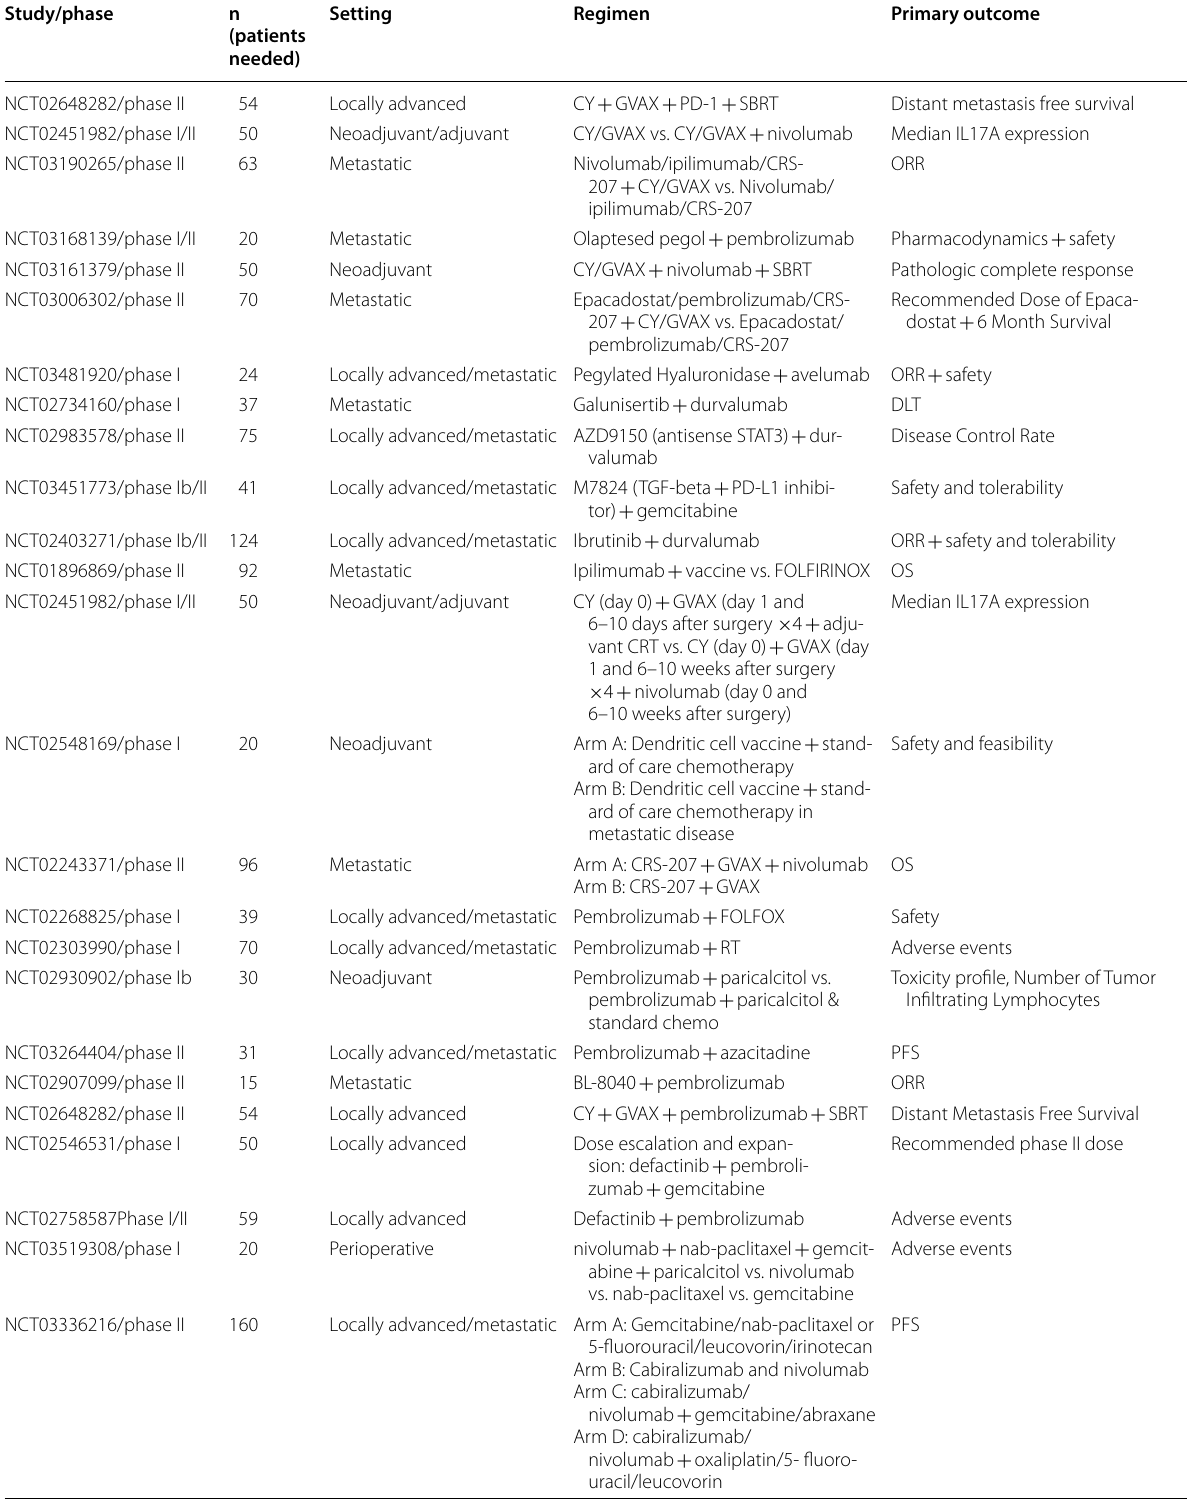
Table 3 Ongoing clinical trials investigating combination regimens incorporating systemic therapies and immune checkpoint inhibitors in pancreatic